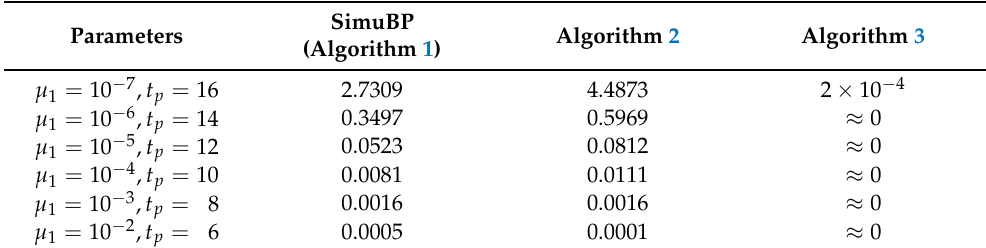
Table 1. Comparison of average computation time (in secs) per sample for simulating 100 data samples